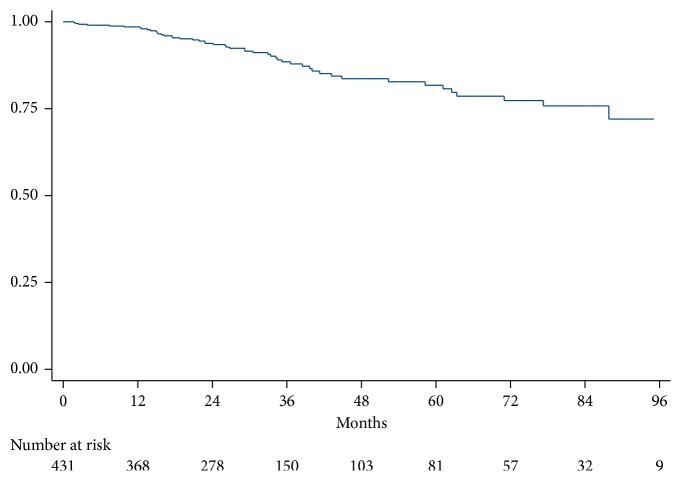
Kaplan–Meier curve illustrating the cumulative survival of the studied cohort. Numbers at risk are reported below the figure.